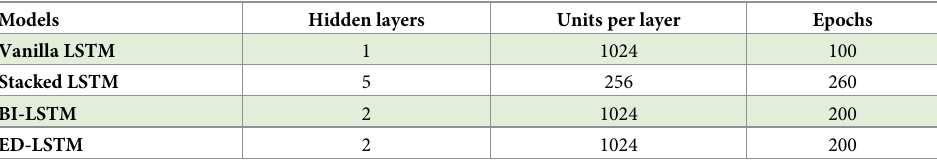
Table 2. Models’ configuration for inter-subject leave-one-out cross validation